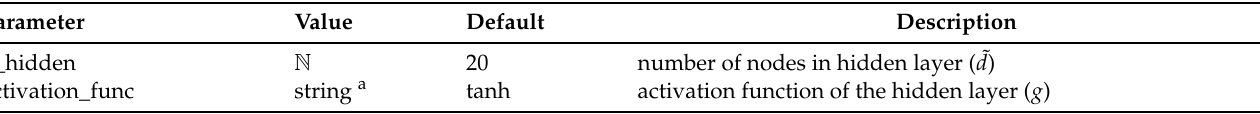
Table 5. Description of the key hyperparameters of the ELM method.